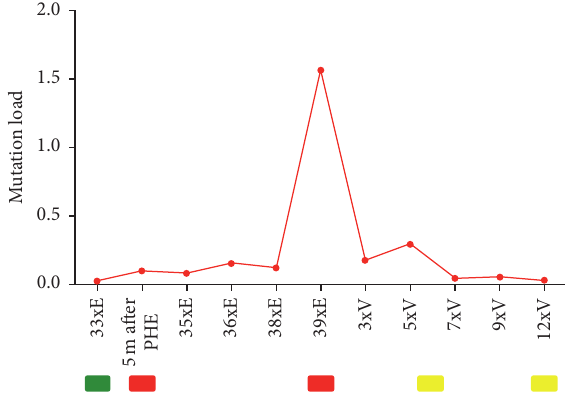
Figure 2: Dynamics of a KRAS mutant clone in plasma samples of the patient in case 2. The red line indicates the frequency of KRAS exon 3 mutation (percentage of alleles) detected in circulating DNA at the indicated time points. Progressive disease occurred after the long-term treatment with anti-EGFR antibodies. After interruption of anti-EGFR therapy; the KRAS mutation load distinctly declined and remained below the limit of detection across subsequent lines of treatment. “E” represents therapy with anti-EGFR antibodies and chemotherapy and “V” therapy with anti-VEGF antibodies and chemotherapy; “PHE” acts for partial hepatectomy and “m” for month. Results of follow-up are indicated below the graphs: green box, partial remission; yellow box, stable disease; and red box, progressive